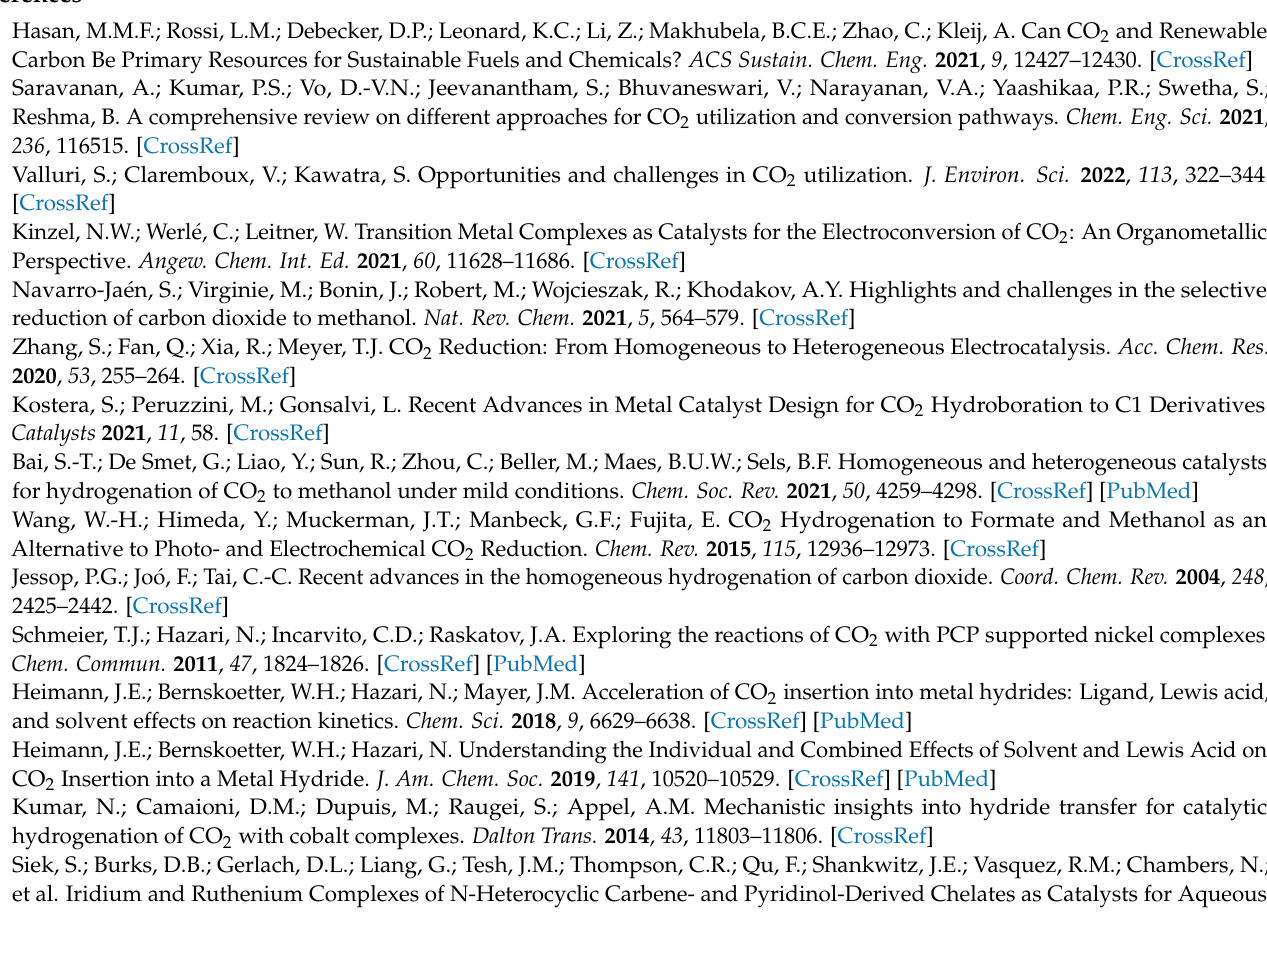
Table S5: DFT-computed energies for species; Table S6: Cartesian coordinates; Scheme S1: Equation used to calculate the hydricity; Scheme S2: The multi-parameter models; Figure S1: Free energy diagram for CO 2 insertion into tBu2 (PCP)Ni–H; Figure S2: Free energy diagram for proton transfer; Figure S3: Free energy diagram for formate pathway and CO pathway; Figure S4: Free energy diagram for CO 2 insertion into TM–H; Figure S5: The representations of 3D and 2D steric maps; Figures S6 and S7: The linear fitting; Figures S8–S11: IRC